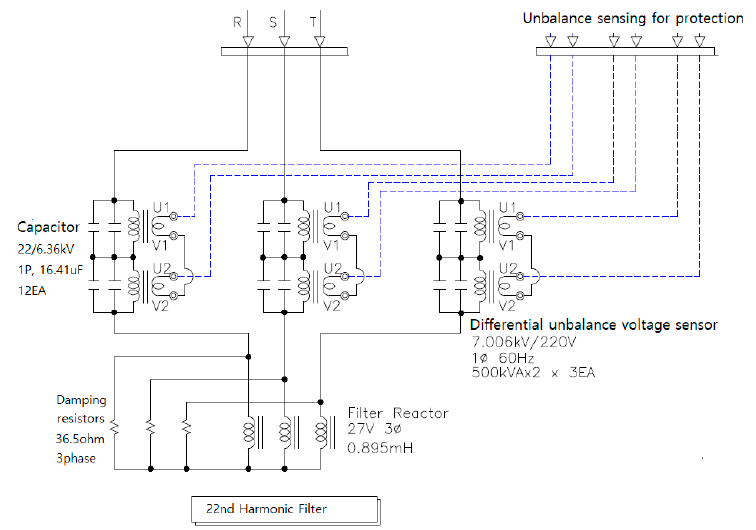
Figure 6. Single line drawing of 22nd